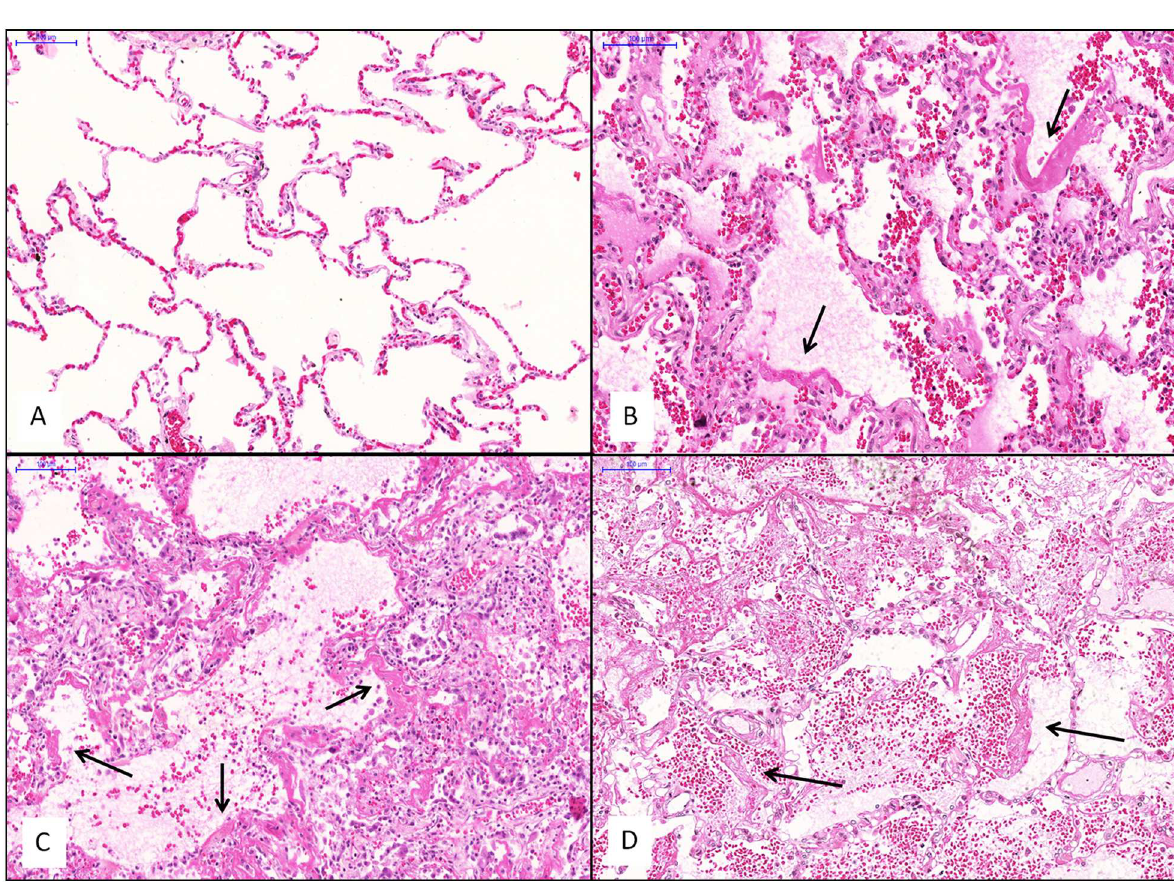
Fig 1. Representative histological images of each group. H&E staining.A: control group; B: DAD group (sepsis); C: DAD group (H1N1); D: DAD group (leptospirosis). Note the hemorrhage present in the leptospirosis group. Arrows: Hyalinemembrane. Bars = 100 μ